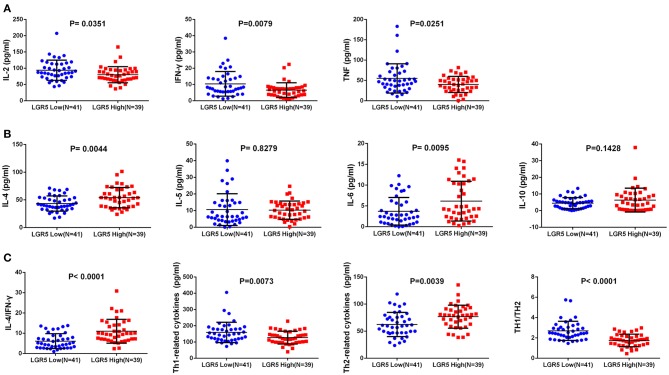
Th1/Th2 cytokine expression in frozen GC tissue samples detected by ELISA. (A) Th1 (pro-inflammatory) cytokines including IL-2, TNF-α, and IFN-γ. (B) Th2 (anti-inflammatory) cytokines including IL-4, IL-5, IL-6, and IL-10. (C) Total Th1 cytokines, total Th2 cytokines, IL-4/IFN-γ cytokines, total h1 cytokines/ total Th2 cytokines ratio. All the cytokines were detected in homogenate protein of fresh tissue (1μg/μl). Abbreviations: ELISA, enzyme-linked immunosorbant assay; GC, gastric cancer; IFN-γ, interferon gamma; IL, interleukin; Lrg5, leucine-rich repeat containing G protein-coupled receptor 5; TNF-α, tumor necrosis factor alpha.